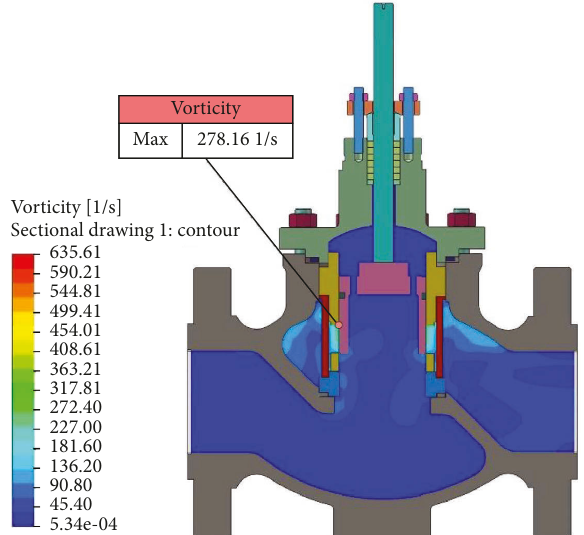
Figure 12: Vortex volume cloud map for 20%